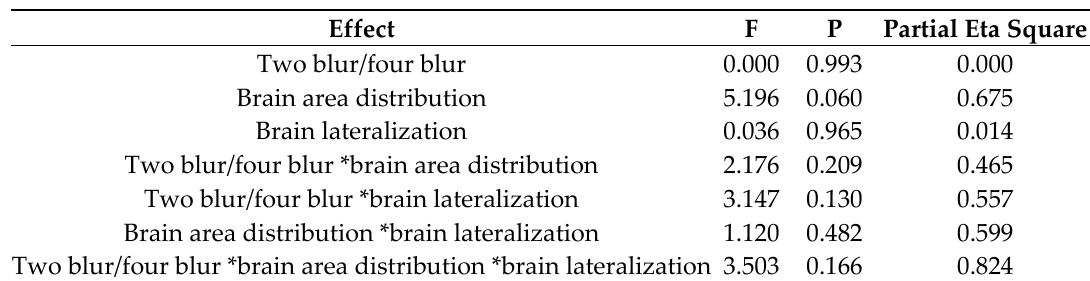
Table 3. The results of 0~200 ms in the control